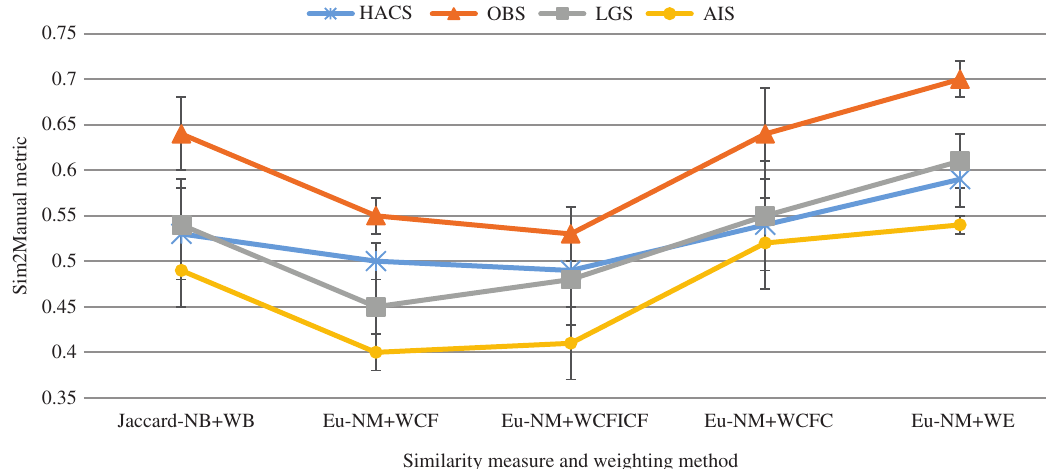
Figure 4: Results of PCI-PSO Without Interactive Iteration for the Four Cases (Average and Standard Deviation of 30